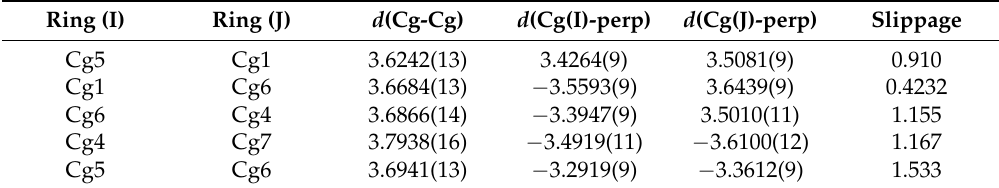
Table 5. Putative π - π stacking interactions [Å] for complex 1 .